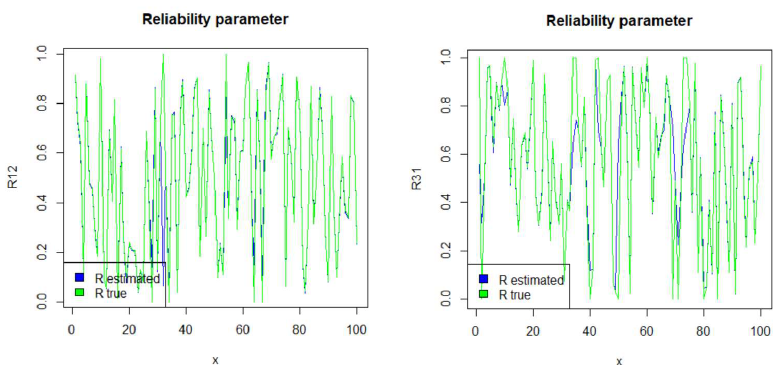
Figure 4. Reliability parameters for the case of censoring at the beginning and/or at the